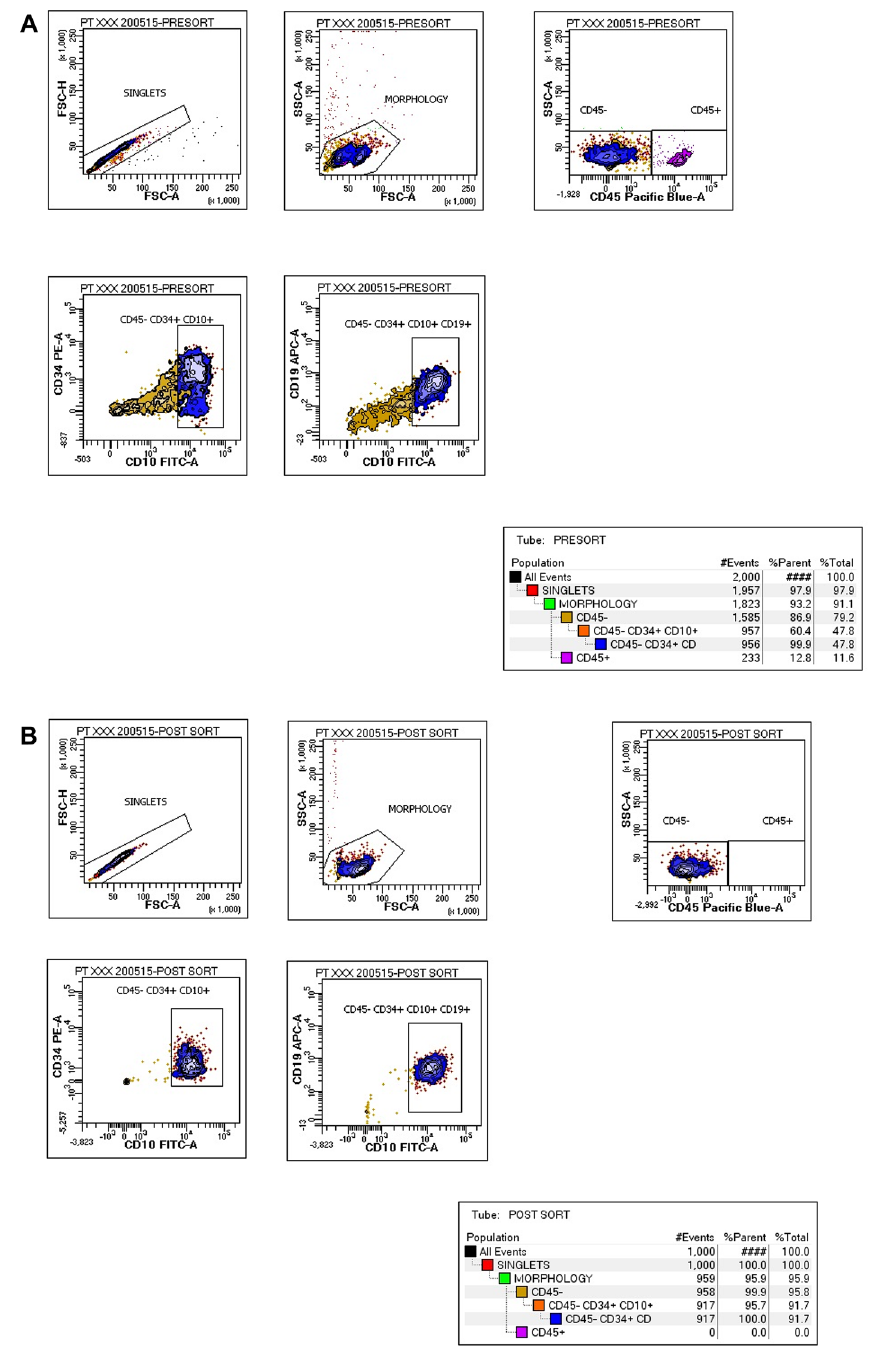
Fig. 1 Immunophenotyp- ing. FACS scatter plots of peripheral blood (PB) or bone marrow (BM) white phase cells from patients diagnosed with B-ALL stained with CD45-PB, CD34-PE, CD10-FITC, and CD19-APC antibodies. A Pre-sort scatter plot showing CD45 as an anchor antibody and CD34 for leukocyte gat- ing . B Post-sort scatter plot showing CD10 + /CD19 + pre-B